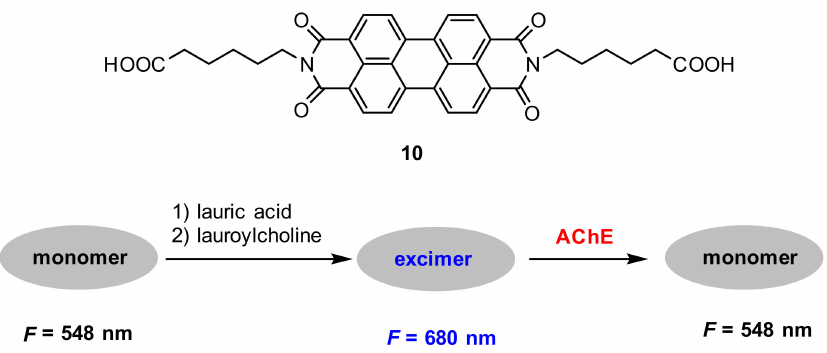
Figure 25. Chemical structure of probe 10 and schematic representation for the detection of